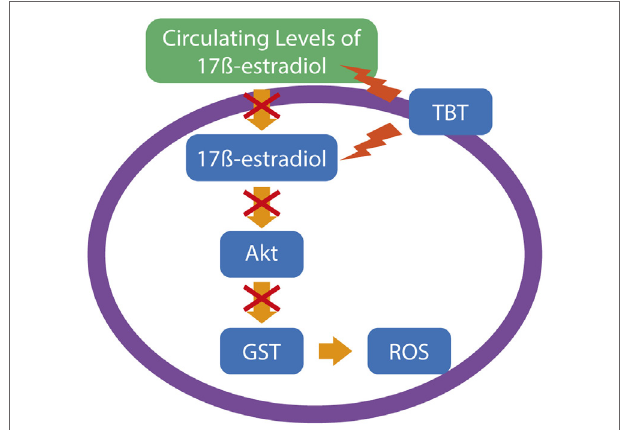
FigURe 1 | A possible pathway for tributyltin (TBT)-generated oxidative stress in neuronal cells. Considering the data of Ishihara and colleagues (41), supported by data of other groups, TBT leads to neuronal reactive oxygen species (ROS) production by a reduction in the estrogen levels, leading to impairments in the Akt signaling and subsequent downregulation of glutathione S -transferase (GST), an important antioxidant mechanism to protect neuronal normal